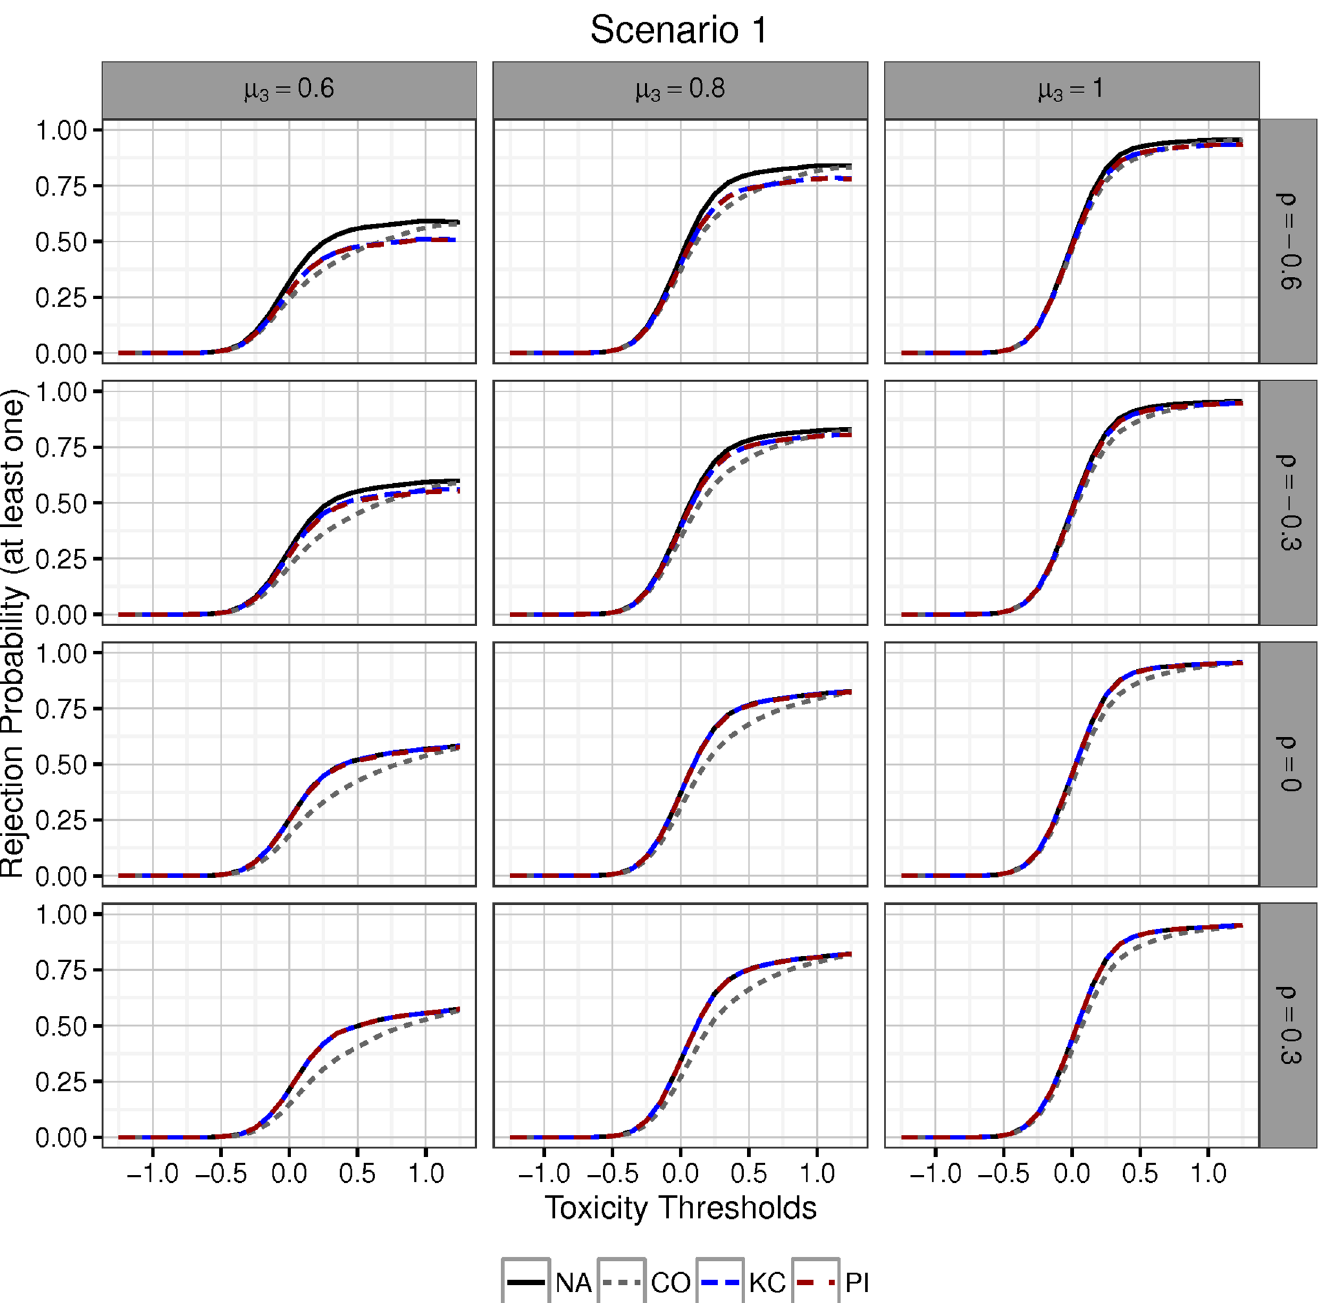
Fig 3. Scenario 1; Power of different two-step procedures as a function of the toxicity thresholds. High values of the toxicity threshold (definedto be the same in each group) imply more treatments are selectedfor efficacy testing. Rows correspondto different values of ρ 2 { − 0.6, − 0.3, 0, 0.3}; columnscorrespondto values of α 3 2 {0.6, 0.8, 1} in the linear scenario(see also the main text). As ρ increases,the regionwhere the adjustedapproaches dominatethe conservative procedurein terms of power, increasesin area. This behaviour acceleratesfor highervalues of α 3 .